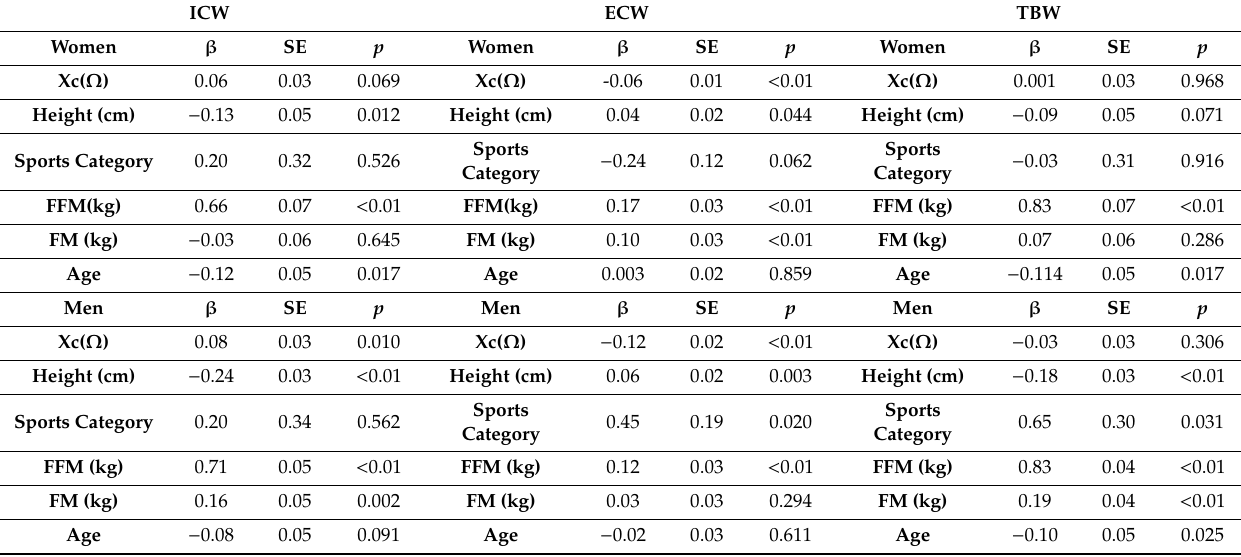
Table 5. Linear and multiple regression analysis between Xc and ICW, ECW and